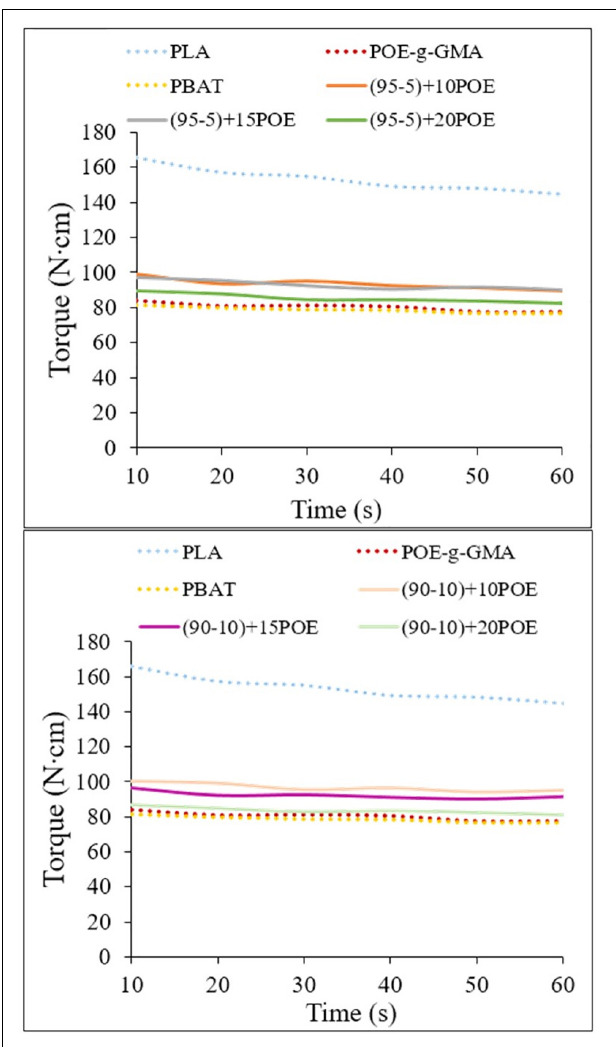
FIGURE 2 | Torque trends for pure polymers and differences with ternary blends.